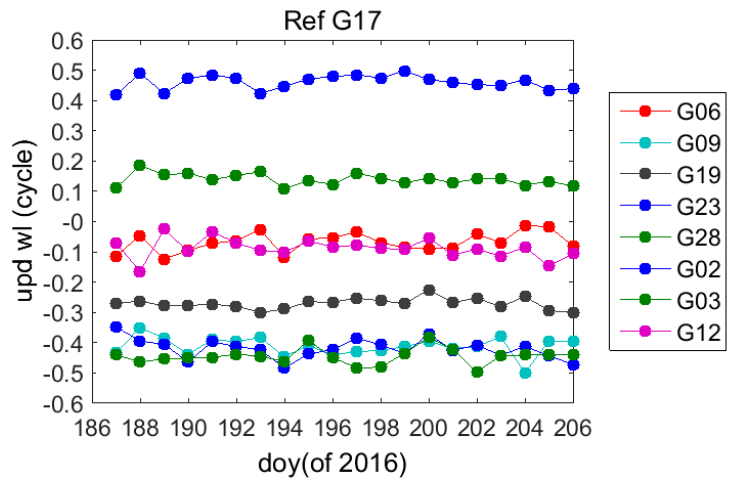
Figure 4. GPS satellite wide-lane ambiguity and number of single-difference ambiguities for calculation.